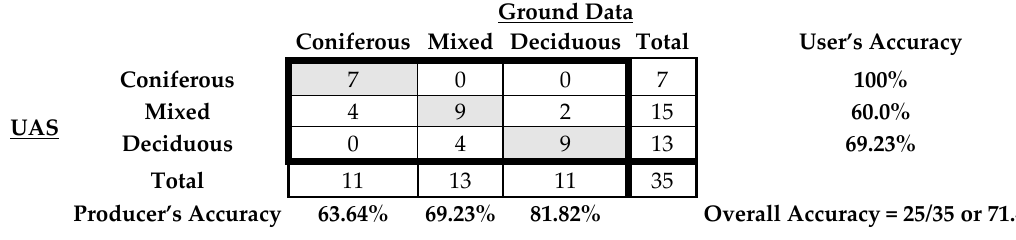
Table 7. CFI plot-registered UAS orthomosaic subsample thematic map error matrix. Ground (reference) data are represented by the CFI plots and Unmanned Aerial Systems (UAS) data are derived from the corresponding orthomosaic.